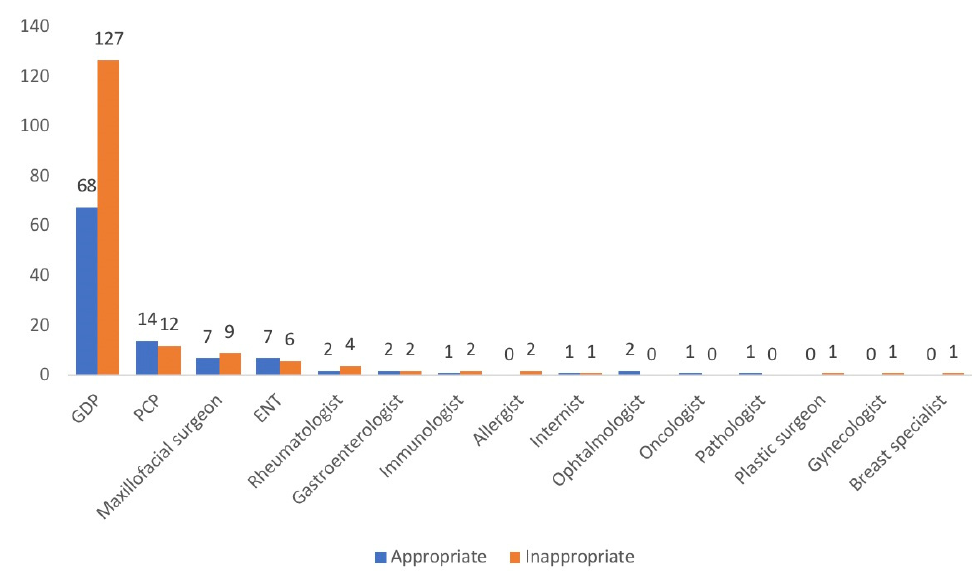
Figure 3. Appropriateness of the reference diagnosis based on the specialty of the referring